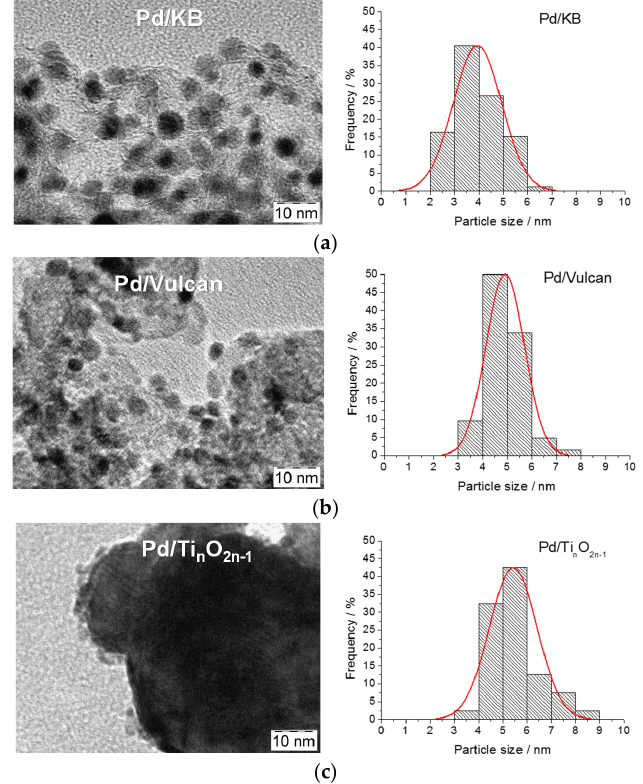
Figure 2. TEM micrographs for the Pd-based catalysts: ( a ) 30% Pd/KB; ( b ) 30% Pd/Vul; ( c ) 30% Pd/Ti n O 2 n –1 .